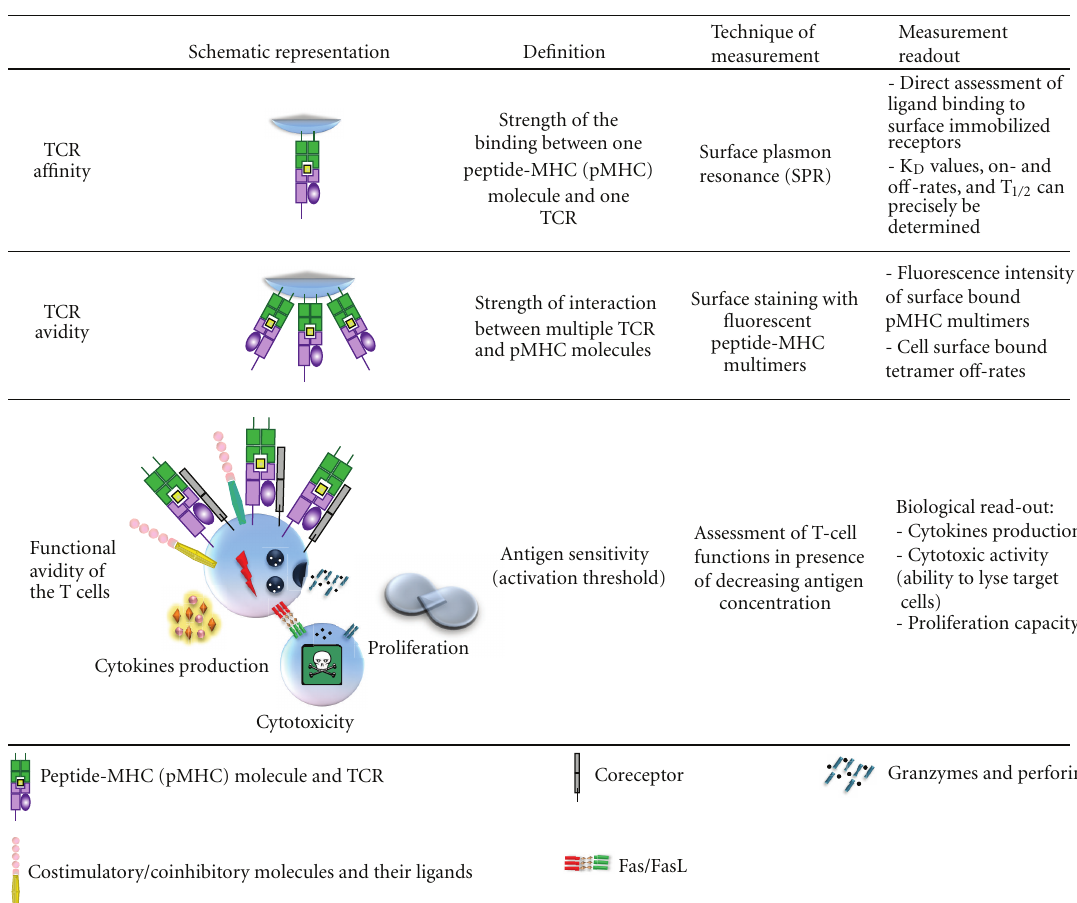
Figure 1: Schematic representation, definition, technique of measurement and readout of TCR a ffi nity and functional